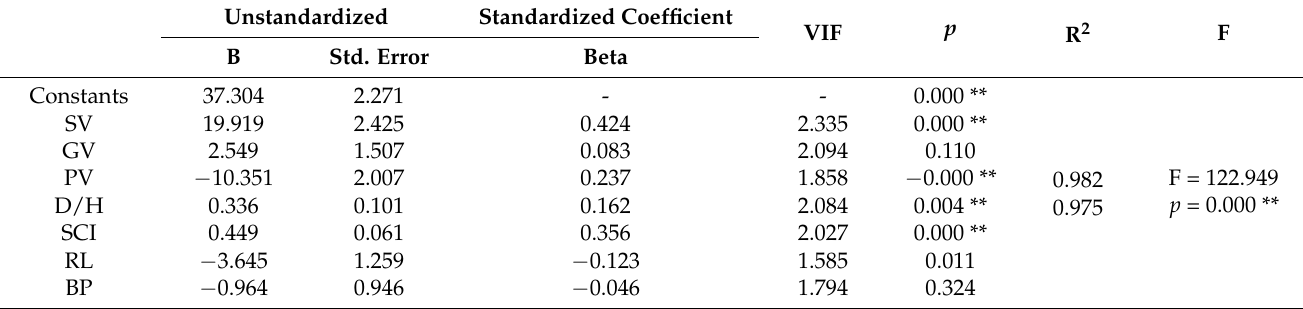
Table 5. Linear regression model of correlation significant spatial features with